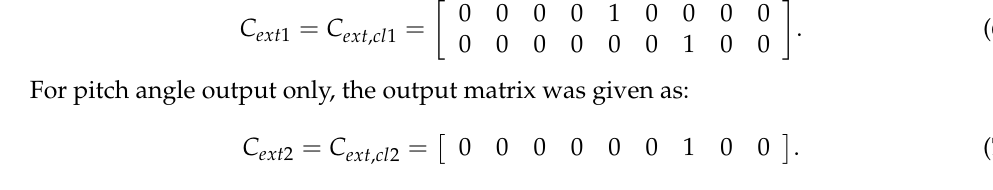
Table 1. Stability and control derivatives.